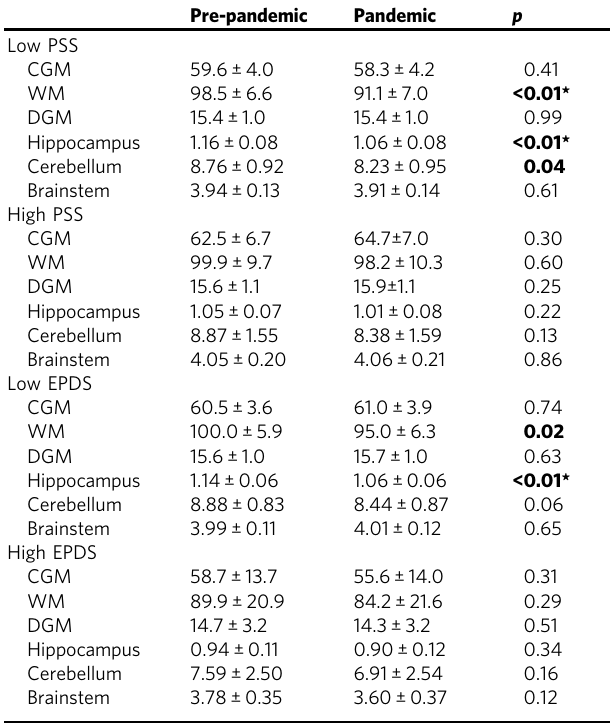
Table 4 Comparisons of brain lobe surface area (cm 2 )/LGI/ sulcal depth (mm) (least squares mean ± standard error) between pre-pandemic and pandemic cohorts from the generalized estimating equations for the associations between cohort status (0: pre-pandemic; 1: pandemic) and brain lobe surface area/LGI/sulcal depth of combined four brain lobes, adjusting for gestational age at MRI (weeks) and fetal